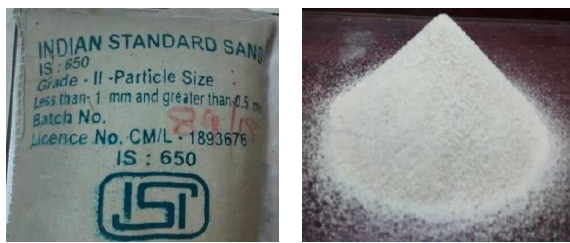
Figure 4. Grade-II: Less than 1mm greater than 0.5 mm.